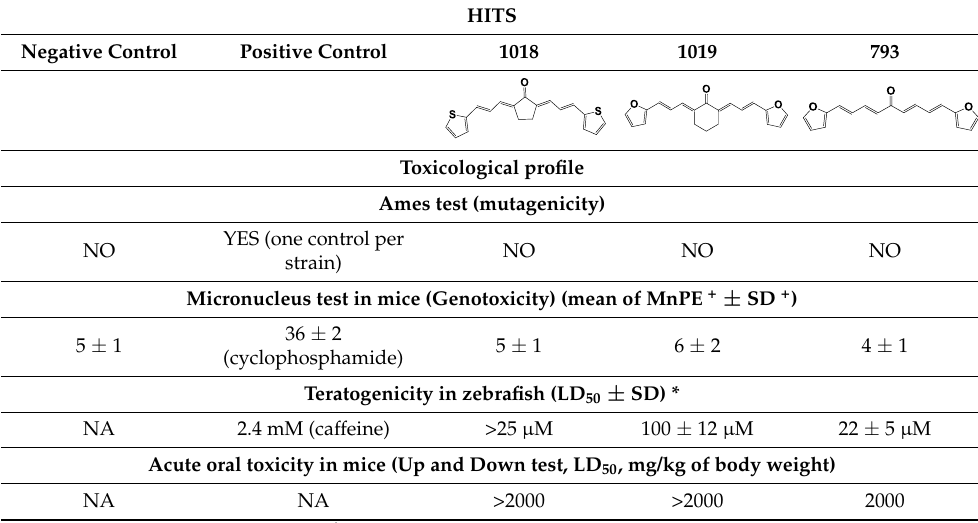
Table 1. Toxicology profile of compounds 1018 , 1019, and 793 .